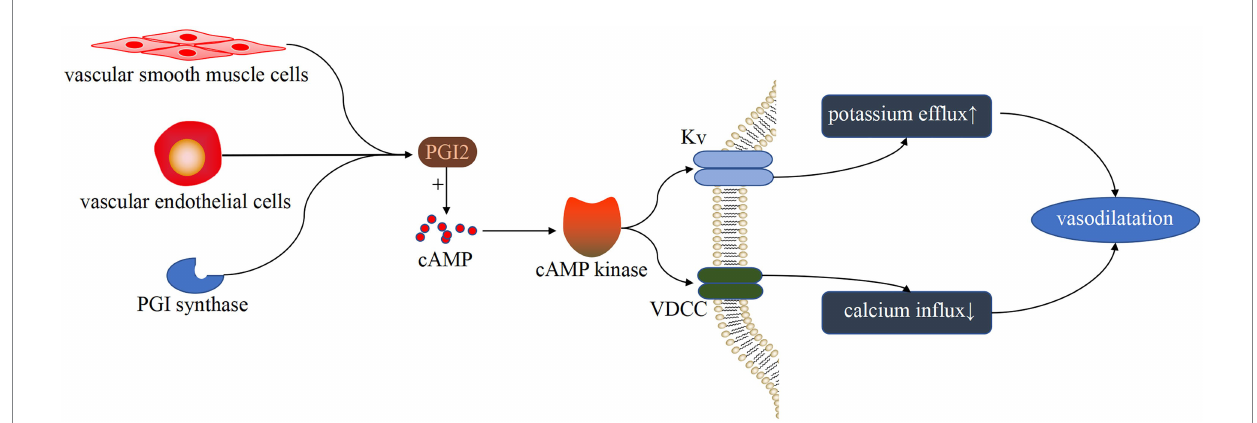
FIGURE 4 Vasodilatation pathway induced by PGI. Under the catalysis of PGI synthase, endothelial cells and vascular smooth muscle cells produce PGI. After binding to G protein-coupled receptors, PGI activates the cAMP pathway and inhibits the activity of VDCC and KV, resulting in a decrease in K + efflux and Ca + influx, as well as